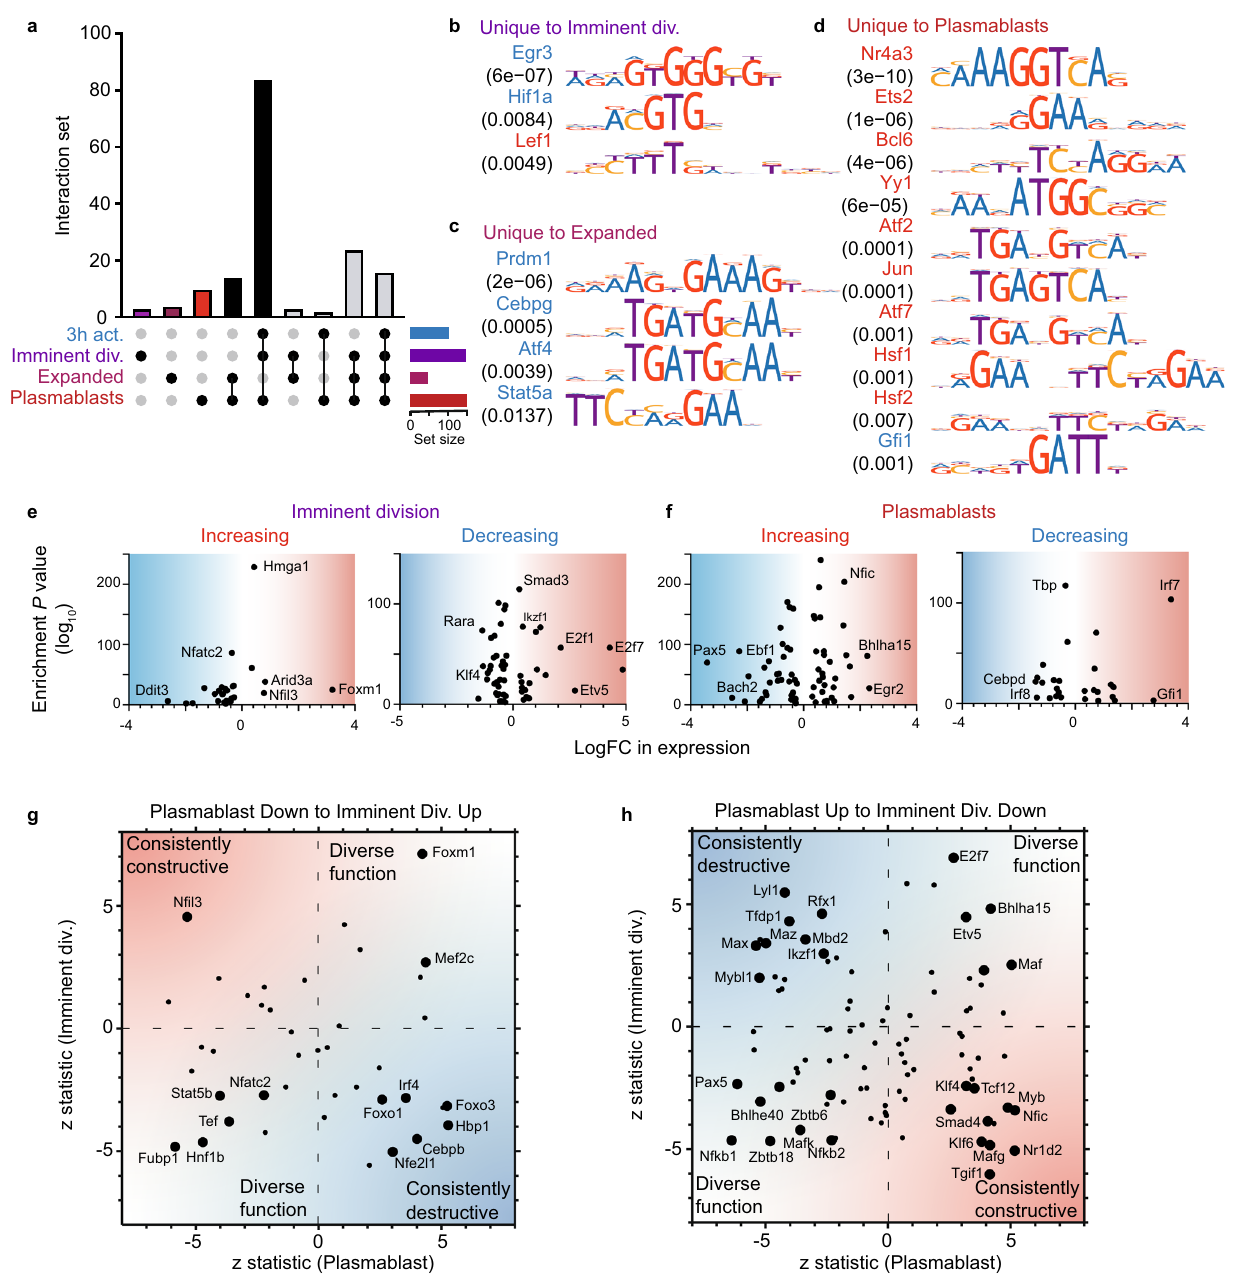
Fig. 4 Numerous transcription factors regulate B-cell differentiation via 3D genome organization. a Upset plot showing shared and unique enriched motifs in DIP patterns that are exclusively increasing or decreasing at the transitions. The vertical bars indicate the number of motifs shared between the patterns and the black dots indicate the patterns shared. The horizontal bars denote the number of motifs enriched in the pattern. b Motifs enriched uniquely in the exclusively increasing or decreasing 10 h activation to imminent division DIP patterns ranked by adjusted p -value. The color of the motif indicates whether it was enriched in the increasing (red) or decreasing (blue) DIPs pattern. c Motifs enriched uniquely in the exclusively increasing or decreasing imminent division to expanded patterns ranked by adjusted p -value. d Motifs enriched uniquely in the exclusively increasing expanded to plasmablasts patterns ranked by adjusted p -value. e The adjusted p -value ( − log10) of the motifs enriched in the exclusively increasing or decreasing 10 h activation to imminent division DIP patterns plotted as a function of logFC of expression at that transition. Blue shading represents decreased expression, red represents increased expression. f The adjusted p -value ( − log10) of the motifs enriched in the exclusively increasing or decreasing expanded to plasmablasts DIP patterns plotted as a function of logFC of expression at that transition. Blue shading represents decreased expression, red represents increased expression. g The z -statistic of expression for the 10 h activation to imminent division transition plotted against the z -statistic of expression for the expanded to plasmablasts. The genes plotted correspond to motifs enriched in the exclusively increasing 10 h activation to imminent division DIP pattern and exclusively decreasing expanded to plasmablasts DIP pattern. Labeled genes are signi fi cant in both transitions (FDR<0.05). Blue shading represents potentially destructive factors, red represents potentially constructive factors. h The z -statistic of expression for the 10 h activation to imminent division transition plotted against the z -statistic of expression for the expanded to plasmablasts. The genes plotted correspond to motifs enriched in the exclusively decreasing 10 h activation to imminent division DIP pattern and exclusively increasing expanded to plasmablasts DIP pattern. Labeled genes are signi fi cant in both transitions (FDR<0.05). Blue shading represents potentially destructive factors, red represents potentially constructive factors. Source data are provided as a Source Data fi